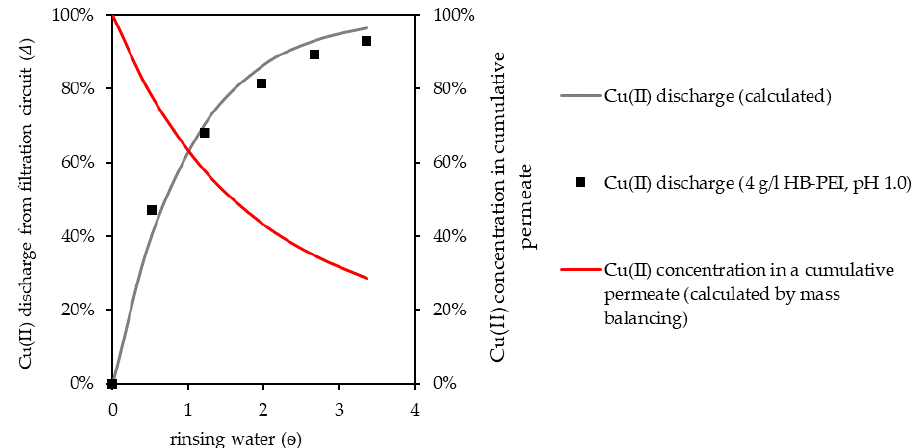
Figure 8. HB-PEI regeneration by pH decrease and Cu(II) discharge from the filtration circuit by rinsing with water. Cu(II) concentration in cumulative permeate is referenced to initial Cu(II) concentration in the filtration circuit.